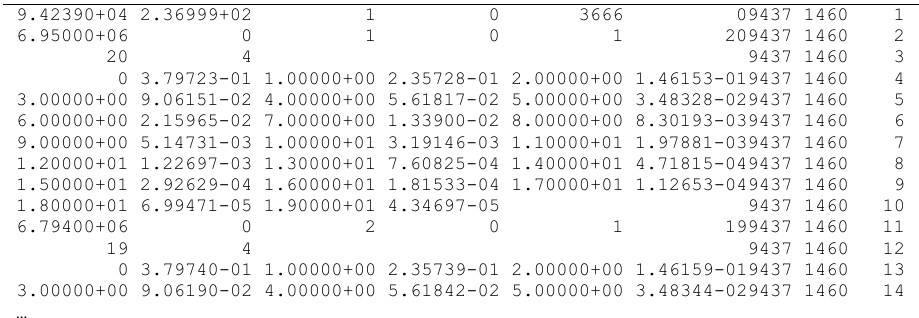
Table 3. Main text lines of beta-delayed fission gamma spectrum of n+ 241 Pu fission in ENDF-6 format (MF=1, MT=460, normalized beta-delayed fission gamma spectrum as function of time)